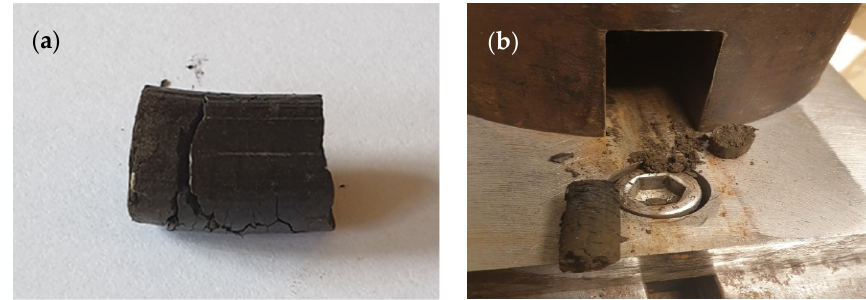
Figure 3. Sludge-derived pyrochar pellets containing equal amounts of wood ash and lignin as binders: ( a ) cracked pellet; ( b ) disintegrated pellet exiting from the opening of the press channel.